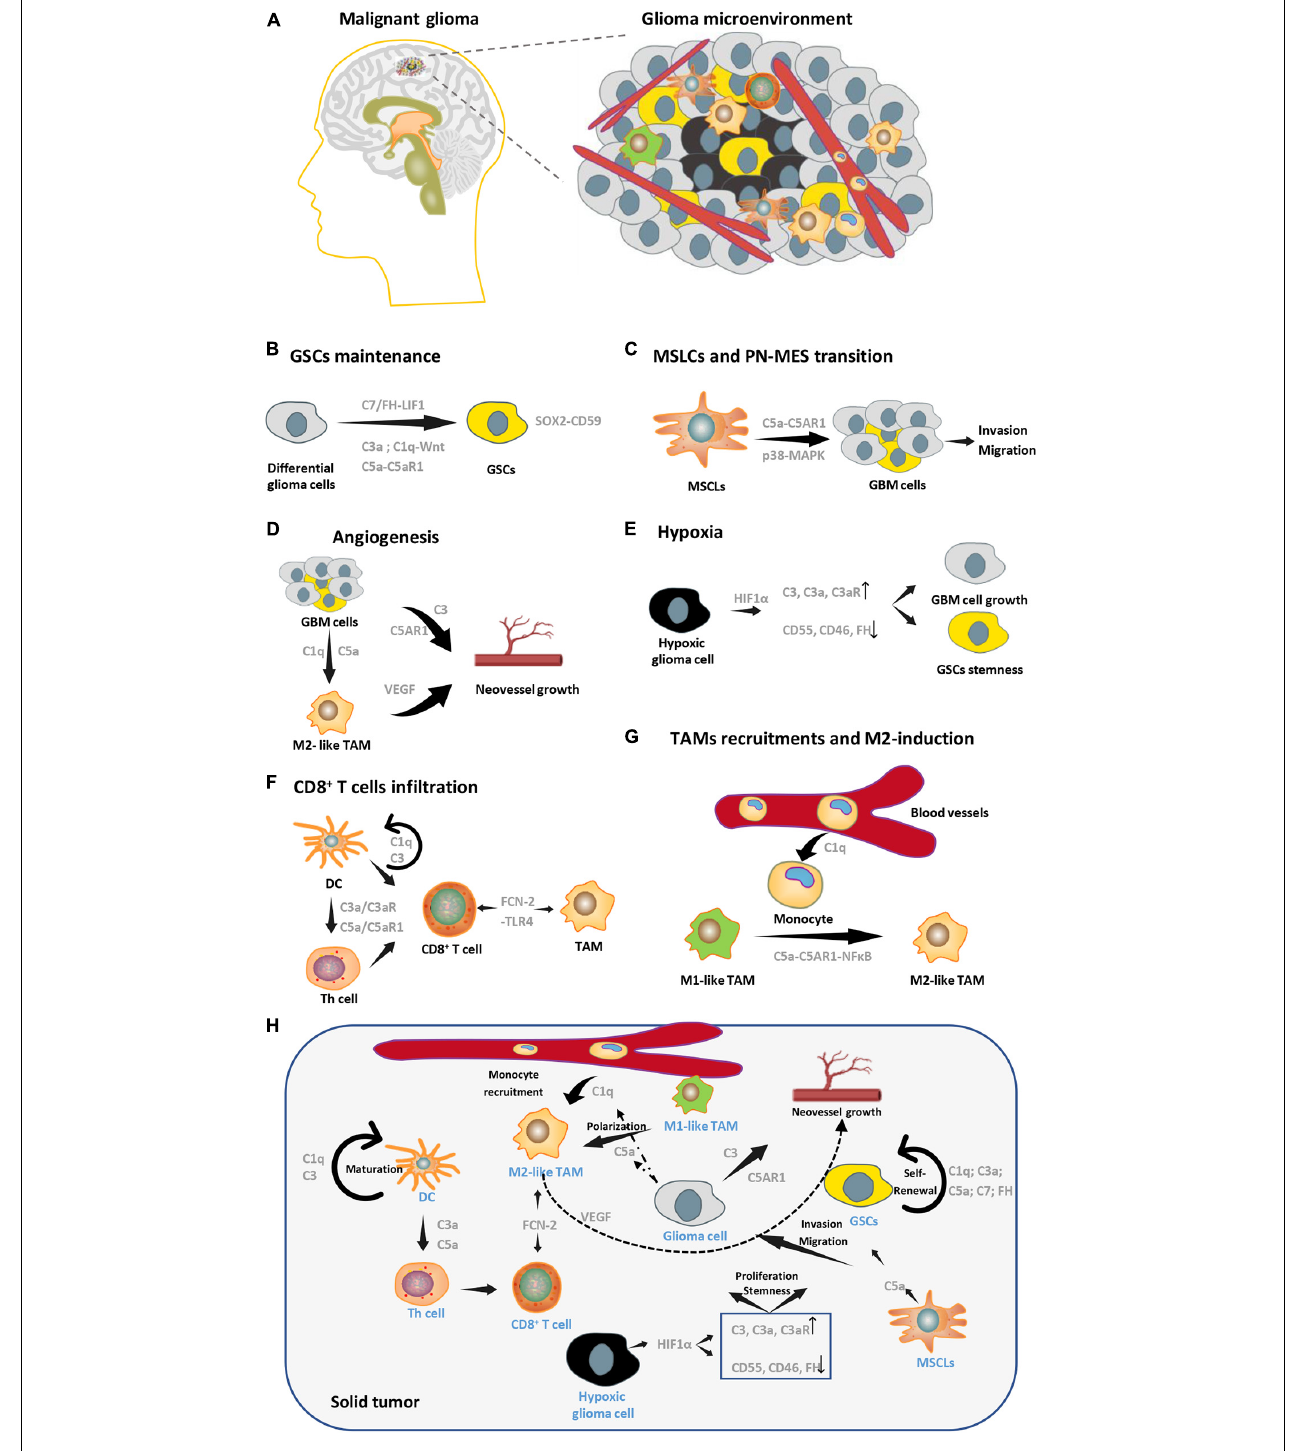
FIGURE 2 | Complement pathways in glioma microenvironment. (A) A brief schematic diagram of glioma microenvironments. (B) Complement molecules (C3a, C1q, C5a, and C7) can promote GSCs stemness maintenance. (C) C5a secreted by MSLCs enhances invasion and migration of GBM cells. (D) Complement pathways can enhance angiogenesis by targeting both tumor cells and M2-TAMs in GBM. (E) Expression patterns of complement molecules change in hypoxia, which facilitates GSCs stemness and GBM growth. (F) C3 and C1q are essential for DC’s maturation, maturated DC can regulate the function of Th cell by C3a-C3aR and C5a-C5aR1 axis, which affect the infiltration of CD8 + T cells. FCN2 can direct target TAM and CD8 + T cell through its receptor, TLR4. (G) C1q and C5a are essential in recruitment of peripheral monocytes and M2 polarization of macrophages, respectively. (H) A conclusion of multicellular interactions in glioma microenvironments via complement